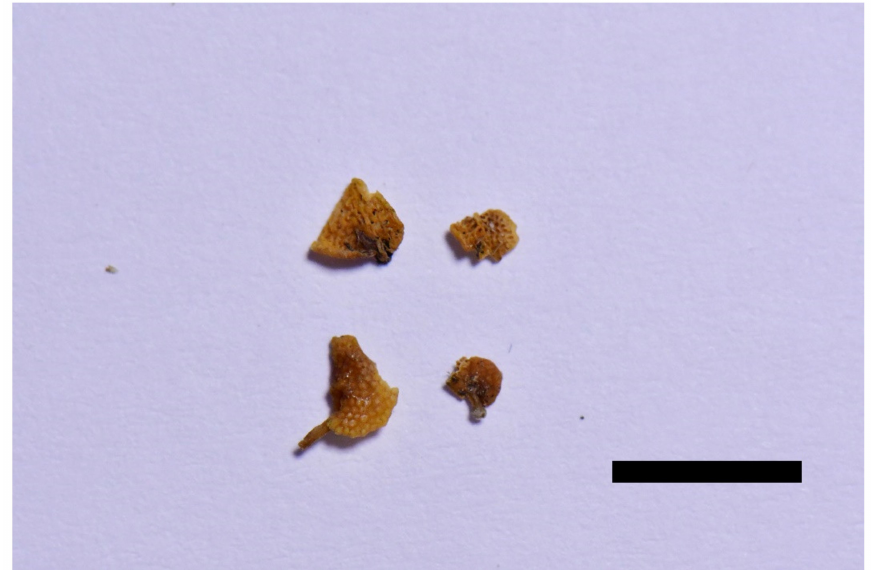
Figure 14. Dried basidiocarps of Favolaschia minutissima (Holotype). Scale bar = 5